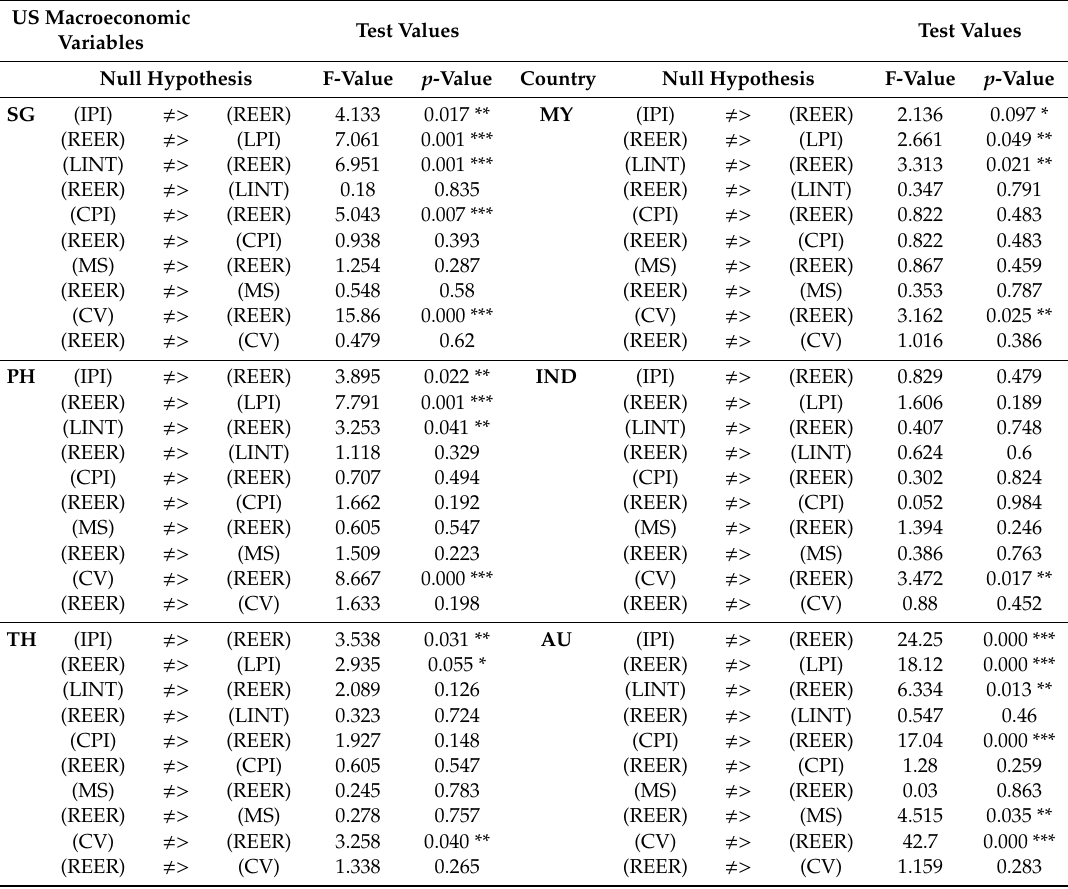
Table 6. Linear Granger-causality test between REERs and the US macroeconomic variables: January 1998–December